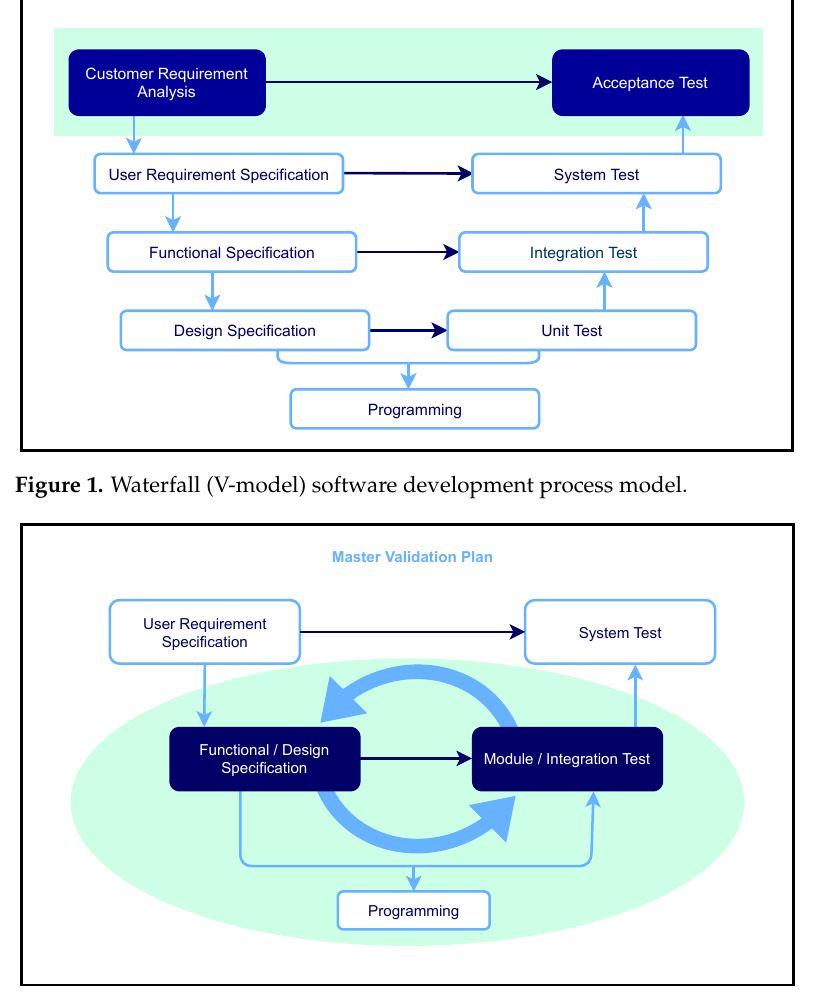
Figure 2. Process model of agile software